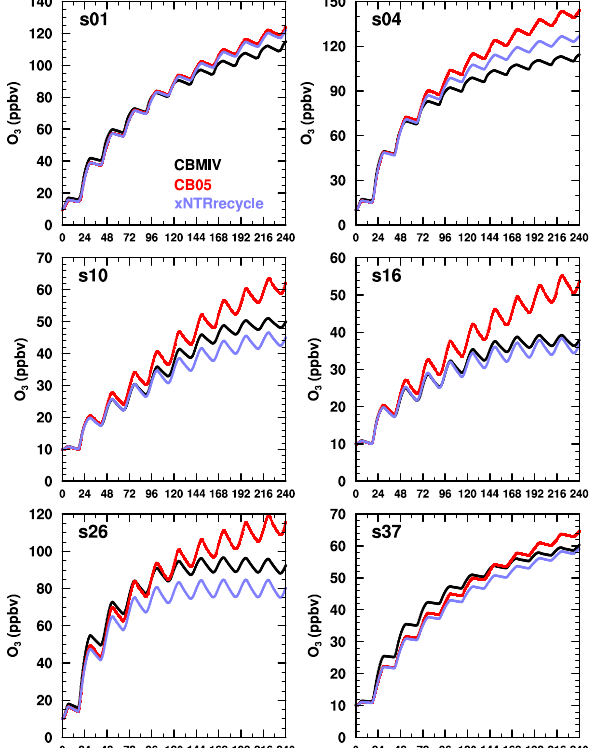
Fig. 10. Example scenario results for sensitivity test allNOxrecycle. Figure 10 . Example scenario results for sensitivity test allNOxrecycle . Ozone mixing ratios 3 Ozone mixing ratios (ppbv) for the base CB05 (red), base CBMIV (ppbv) for the base CB05 (red), base CBMIV (black) and sensitivity test allNOxrecycle 4 (violet) over the 240 hr simulation period. 5 (black) and sensitivity test allNOxrecycle (violet) over the 240h 6 simulation